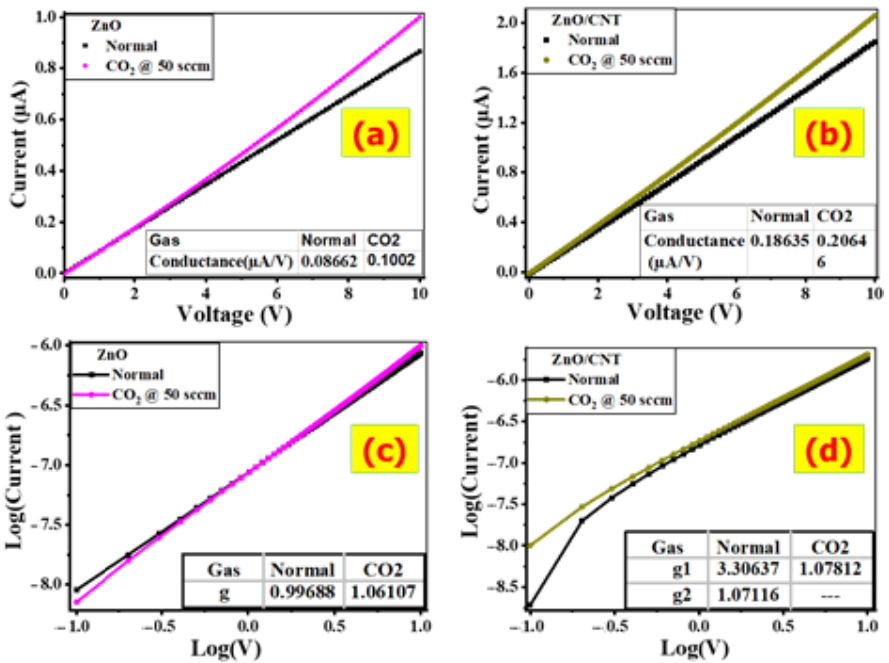
Figure 6. I-V and Log (I)-Log (V) for ( a , c ) ZnO and ( b , d ) ZnO/CNTs films.